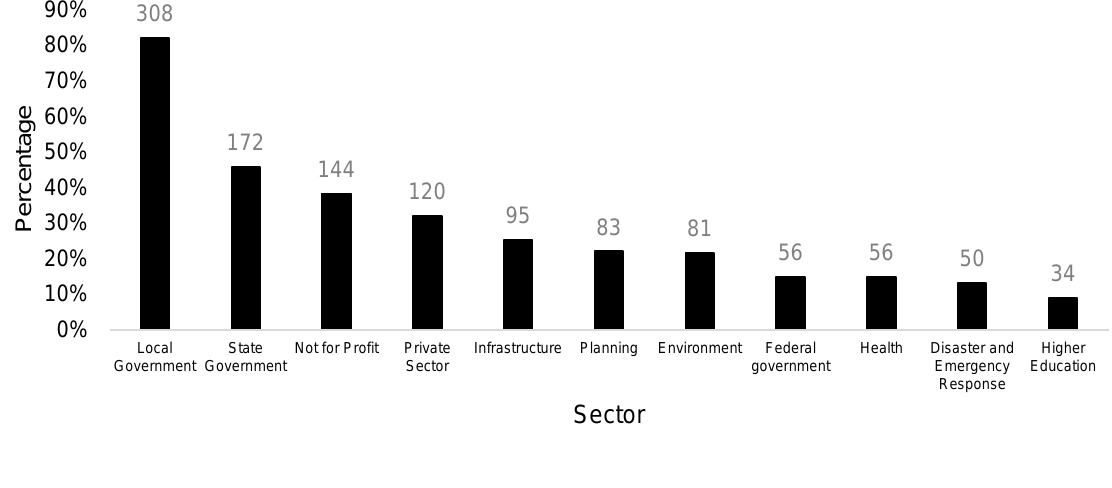
Figure 6 . Sector experience of participatory and deliberative practitioners